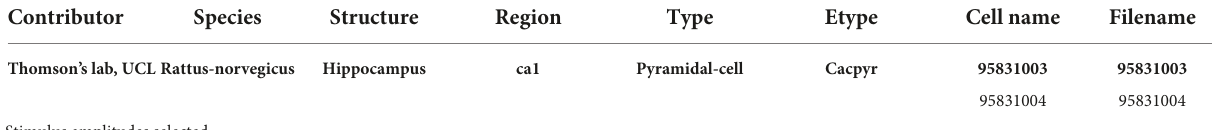
TABLE 2 List of experimental traces, stimuli, features, model and optimization settings adopted for the optimization workflow example. Contributor Thomson’s lab, UCL